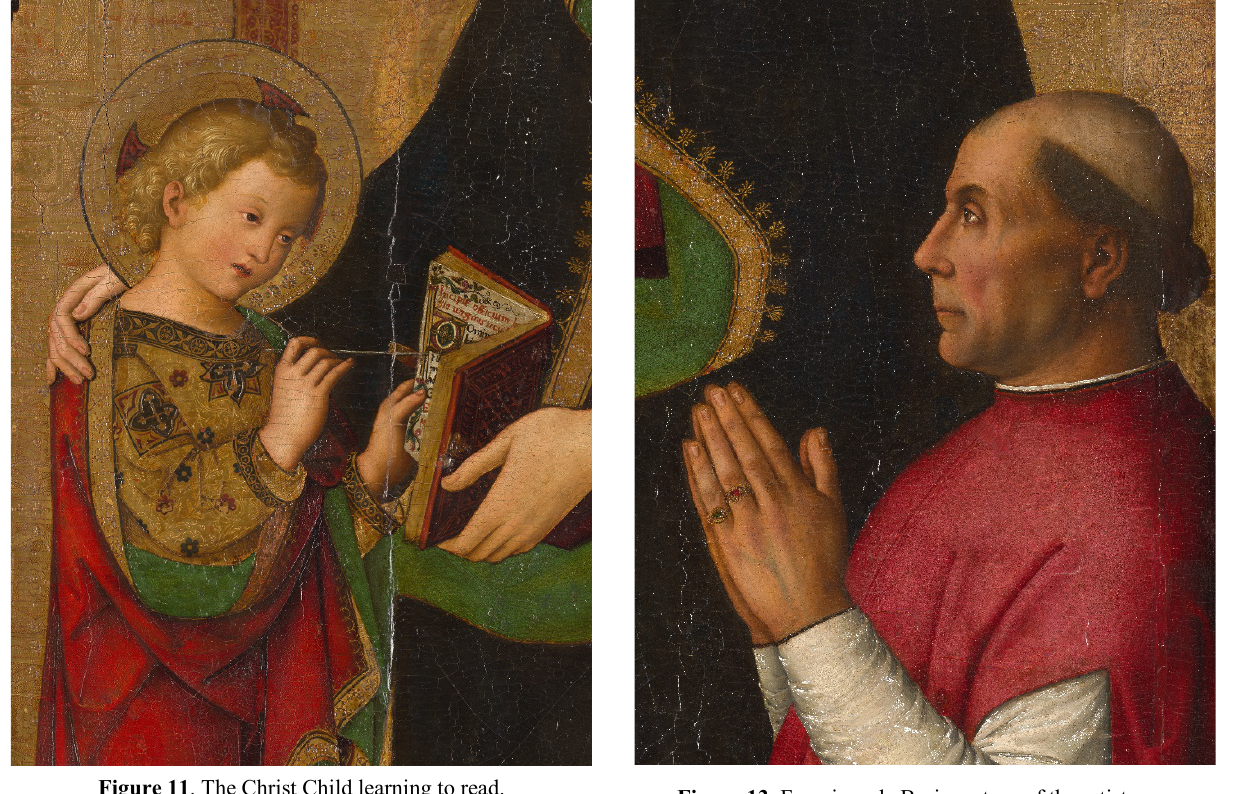
Figure 13 . Francisco de Borja, patron of the artist, was represented in a praying